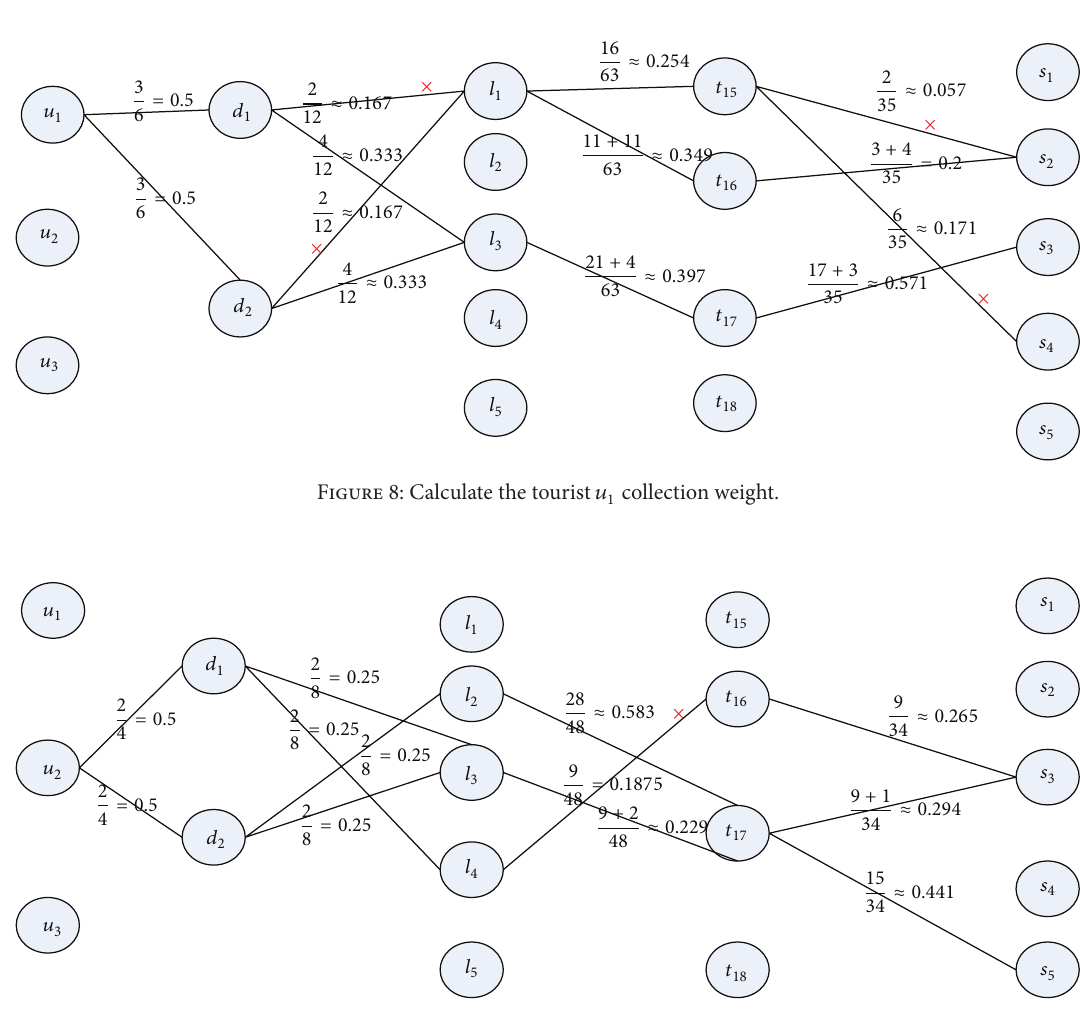
Figure 9: Calculate the tourist 𝑢 2 collection